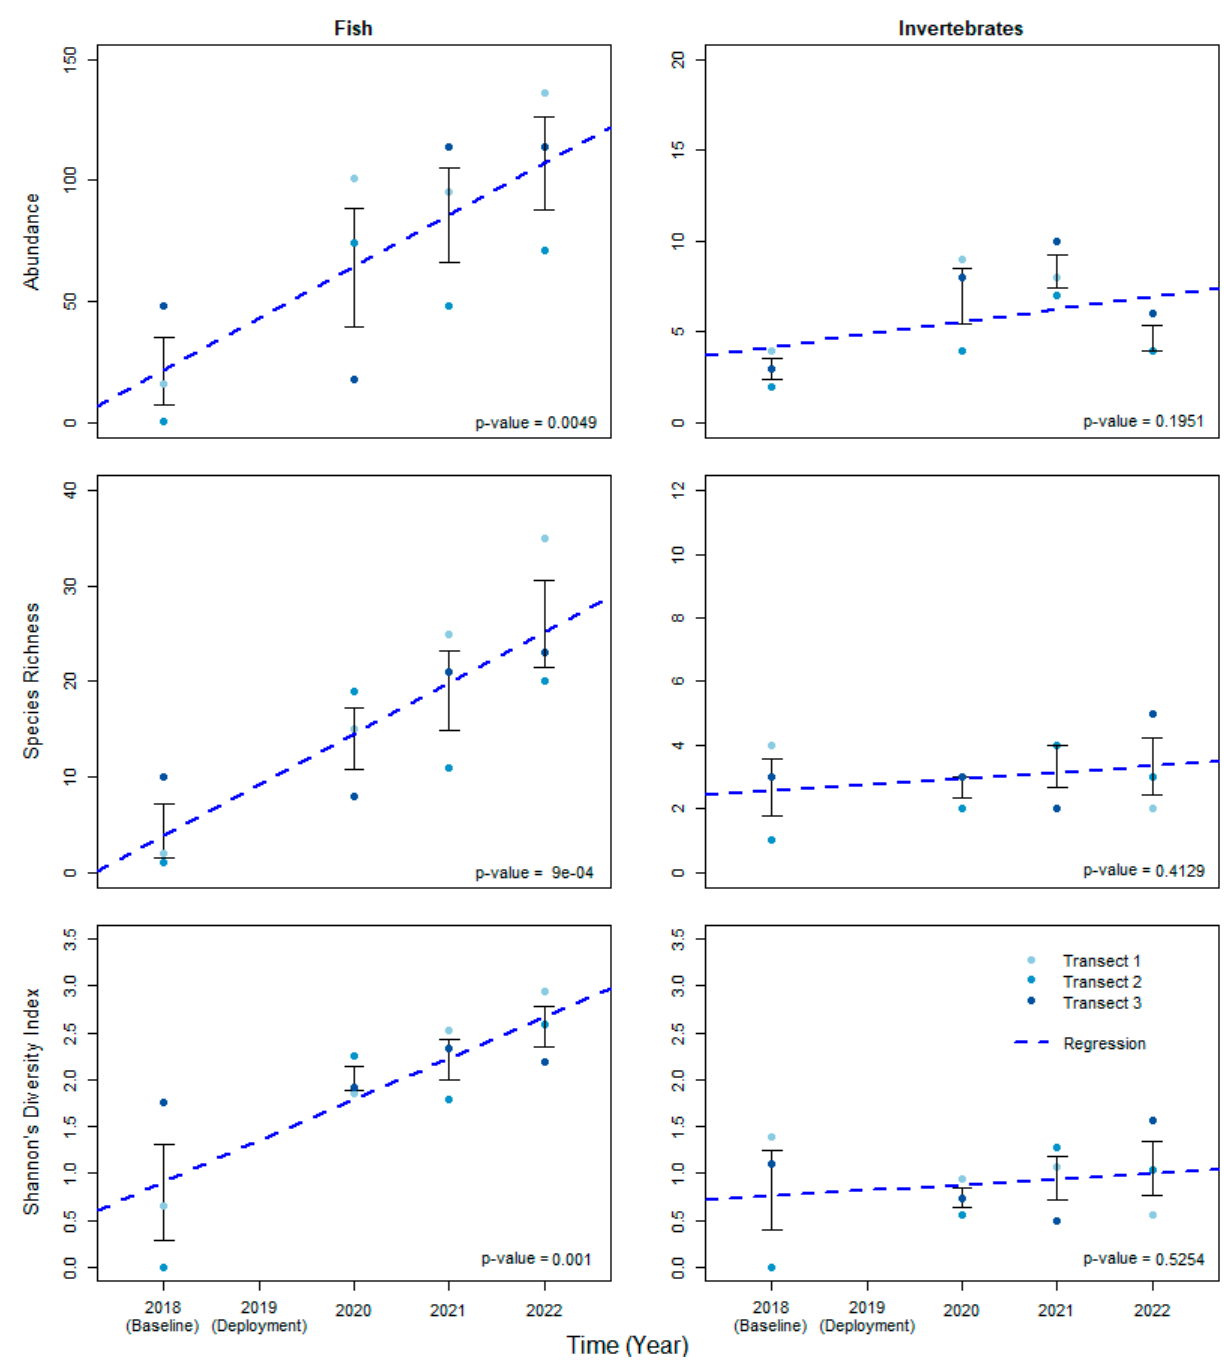
Figure 7. Comparing the mean abundance, mean species richness and mean diversity of fish across time between fish ( n = 75) and invertebrates ( n = 10). Baseline (2018) (Baseline) indicates results before the installation of the Coral Greenhouse. Deployment (2019) (Deployment) indicates the year when the Coral Greenhouse was deployed (no results were collected this year). p -values were calculated by t -tests of the coefficient of the linear model testing if the gradient was equal to 0. Error bars indicate the standard error of each time period. The most abundant fish species were Double-lined Fusilier ( Pterocaesio digramma ), Yel- lowtail Fusilier ( Caesio cuning ), and Brassy Trevally ( Caranx papuensis ). The mean abundance of the top ten species varied over time (Figure